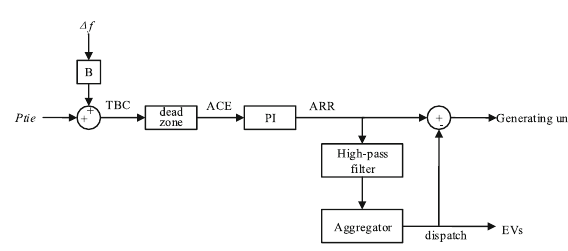
Fig. 5 The control loop with high-frequency components of